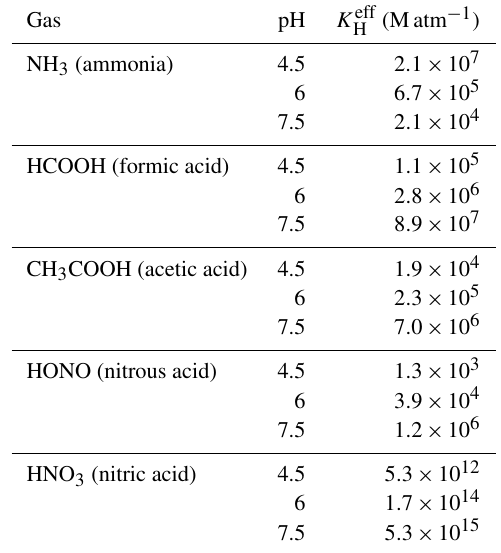
Table 2. K eff of NH 3 and other water-soluble gases at 10 ◦ C and H various